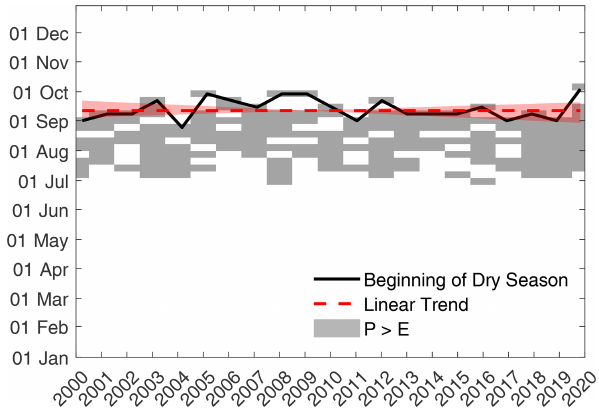
Figure 11. Date of the beginning of the dry season based on gauge- corrected satellite data (black line). The dry season is defined as the portion of the year when open-water evaporation ( E ) exceeds precipitation. Weeks with sufficient precipitation to satisfy E are marked in grey. The dotted red line indicates the linear regression line based on the Sen slope